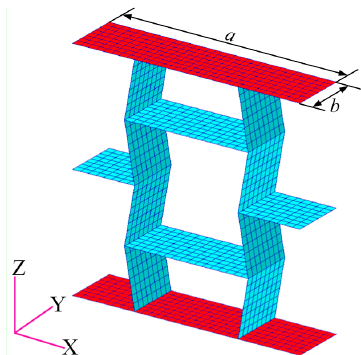
Figure 1. The FE model of the re-entrant hexagonal honeycomb, where the red parts are faceplates and the blue parts are honeycombs. a and b are the length and the width of the faceplate, respectively.